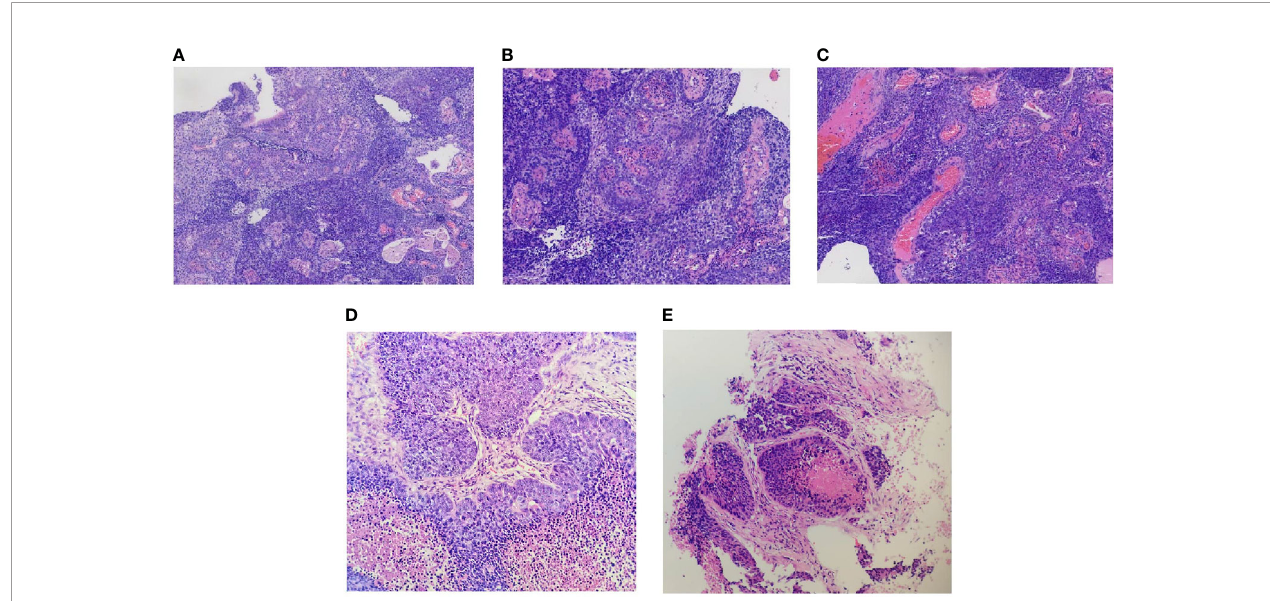
FIGURE 1 | Biopsy of the primary nasopharyngeal neoplasm (A – C) , right upper arm lesion (D) , and lung metastases lesion (E) . (A) Epithelial papillary hyperplasia (hematoxylin and eosin, original magni fi cation ×10). (B) Squamous differentiation (hematoxylin and eosin, original magni fi cation ×20). (C) Base-like arrangement (hematoxylin and eosin, original magni fi cation ×20). (D) Representative images of the metastatic carcinoma in the right upper arm (hematoxylin and eosin, original magni fi cation ×20). (E) Representative images of the metastatic carcinoma in the lung (hematoxylin and eosin, original magni fi cation